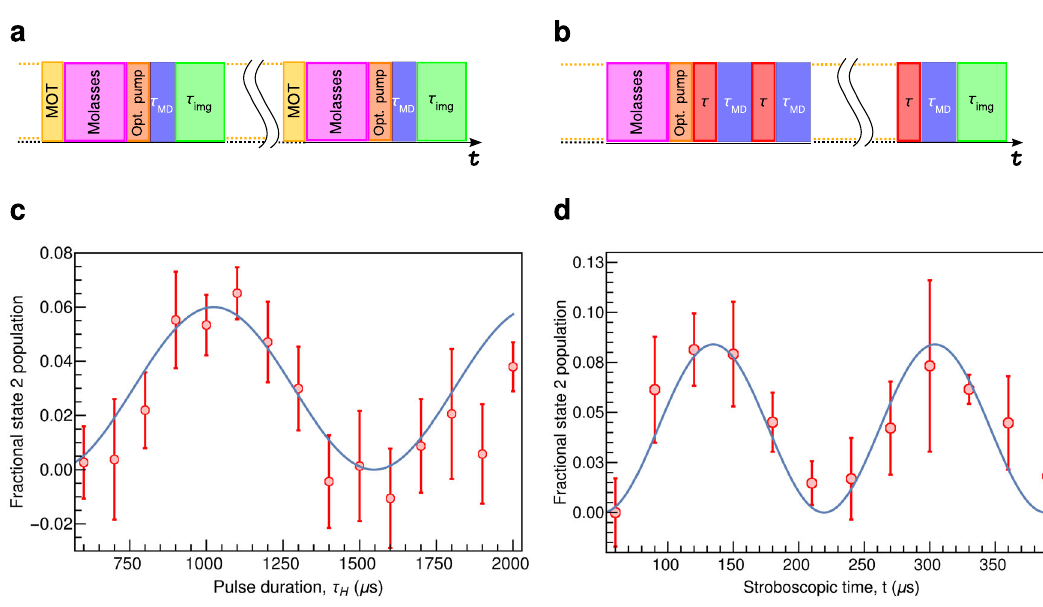
Fig. 2 Nondestructively measured Rabi oscillations. a , b Show respectively the timing sequences for the single-shot (horn used to drive and detect) and the stroboscopic (antenna used to drive and horn to detect) Rabi oscillation measurements. In these panels, τ MD represents the duration of the microwave detection pulse done with the horn antenna. In the stroboscopic protocol in panel ( b ), τ is the duration of the driving pulse of the dipole antenna. The duration of the absorption imaging pulse is represented by τ img . Panels c and d display respectively the single-shot and the stroboscopic Rabi oscillations measured with the same initial conditions (initial atomic state). In panel ( c ), τ H corresponds to τ MD in panel ( a ). The stroboscopic time was varied in steps of 30 μ s for both, excitation and detection (see “ Methods ” ). The error bars correspond to the standard deviation of repeated